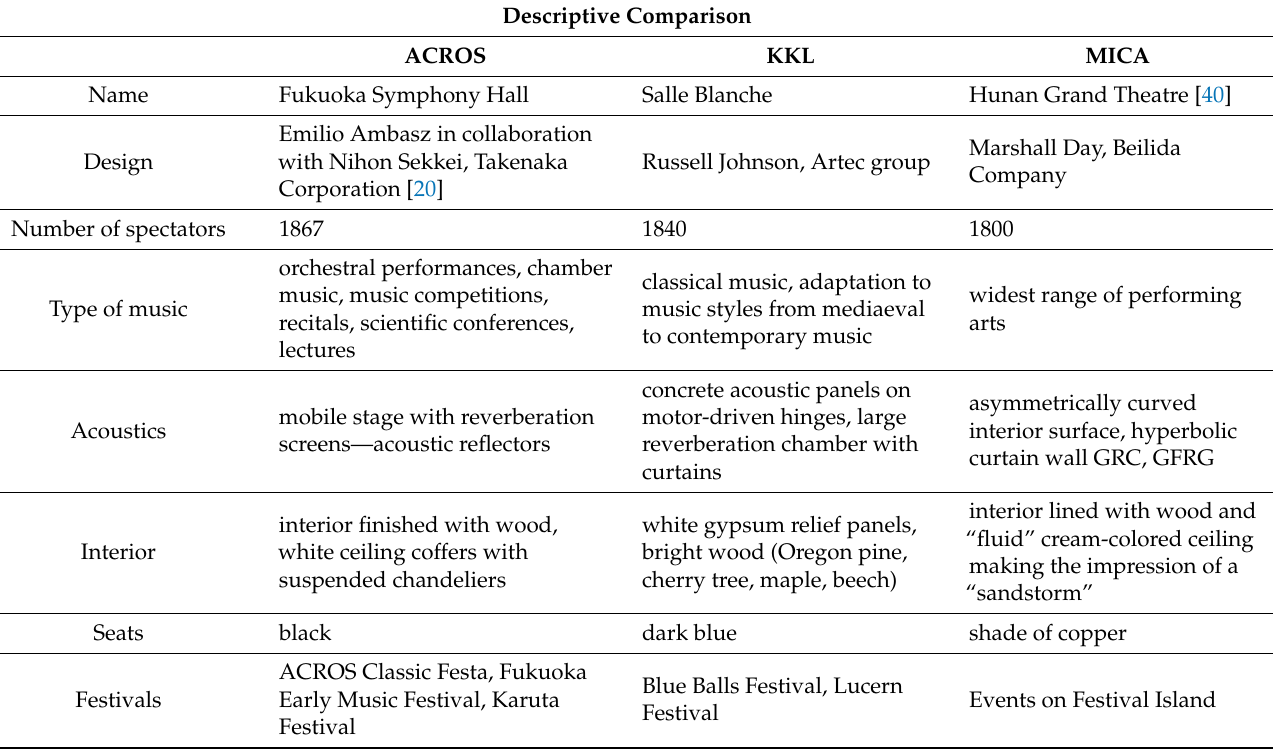
Table 2. Comparison of concert halls in the studied buildings: Fukuoka Symphony Hall, Salle Blanche and Hunan Grand Theatre, summarizing the multicriterial case study—descriptive